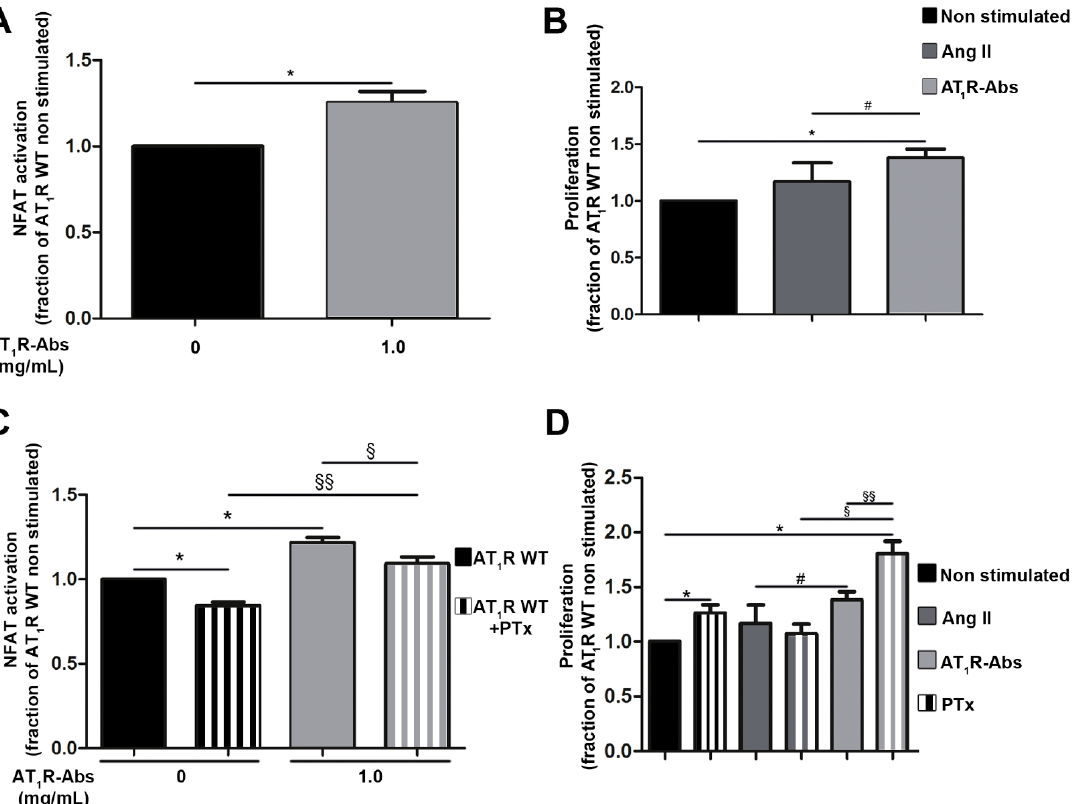
Figure 1. Angiotensin II (Ang II) type 1 receptor auto-antibodies ( AT 1 R-Abs)-mediated G q/11 activa- tion and induction of human microvascular endothelial cells (HMEC-1) proliferation. ( A ) In HMEC- 1s, AT 1 R-Abs stimulation triggered luciferase production mediated by nuclear factor of activated T- cells (NFAT). ( B ) AT 1 R-Abs stimulation but not Ang II (1µM) stimulation led to cell proliferation. ( C ) One hour pre-incubation with pertussis toxin (PTx) did not change NFAT activation or ( D ) cell proliferation induced by AT 1 R-Abs. Cells transfected to over-express wild-type (WT) AT 1 R were stimulated with 1mg/mL AT 1 R-Abs or 1µM Ang II, as indicated, with or without a pre-incubation with 5ng/mL PTx for one hour. SEMs derived from five to eight experiments are shown along with p -values for Wilcoxon or Mann–Whitney tests. (* p < 0.05 as compared with AT 1 R WT without stim- ulation; # p < 0.05 as compared with AT 1 R stimulated with Ang II; § p < 0.05, §§ p < 0.01 as compared with AT 1 R WT pre-incubated with PTx.)